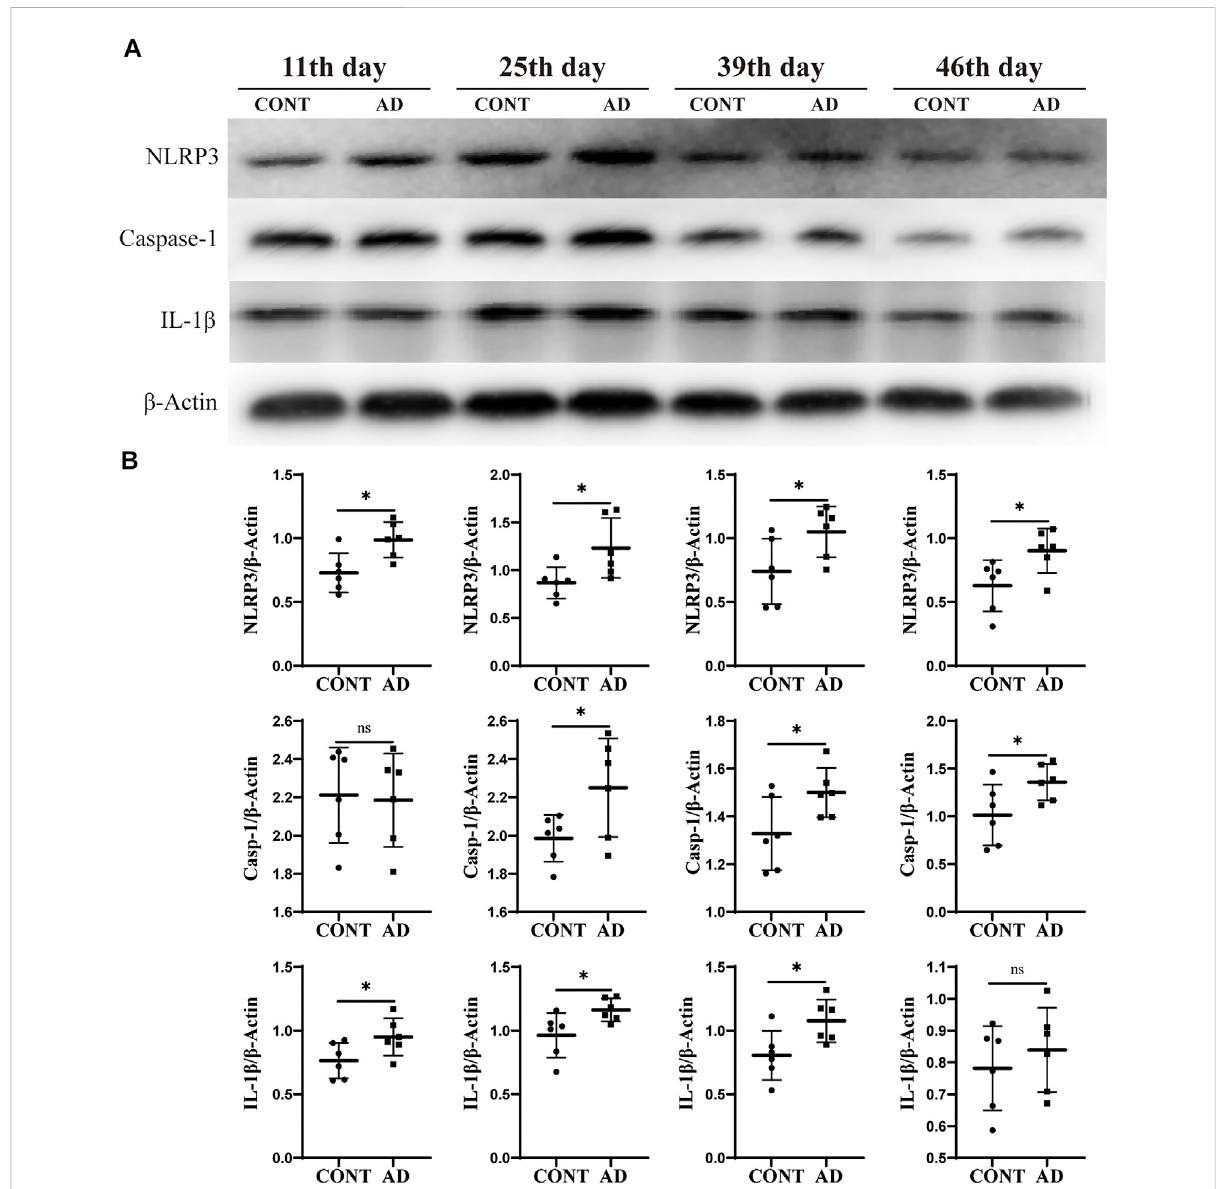
FIGURE 3 Protein expression of NLRP3, caspase-1, and IL-1 β . (A) Western blotting of NLRP3, caspase-1, and IL-1 β expression in mice hippocampus at different time points. (B) Comparison of relative gray values of NLRP3, caspase-1, and IL-1 β in mice hippocampus at different time points. Data are expressed as mean ± SD; n = 6 mice/group. * p < 0.05 vs. CONT group. CONT, normal mice; AD, DNFB-treated